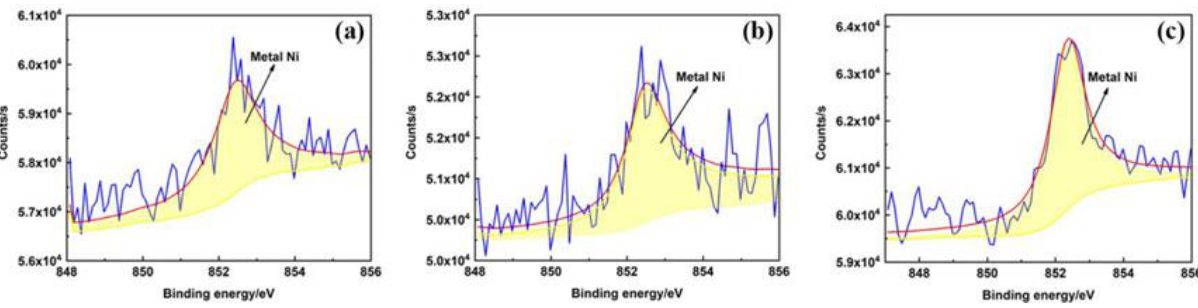
Figure 12. Mo2p peak fitting of 2205 DSS cladding layer under different current. ( a ) 90 A; ( b ) 100 A; ( c ) 110 A. Figure 13. Ni2p peak fitting of 2205 DSS cladding layer under different current. ( a ) 90 A; ( b ) 100 A; ( c ) 110 A.